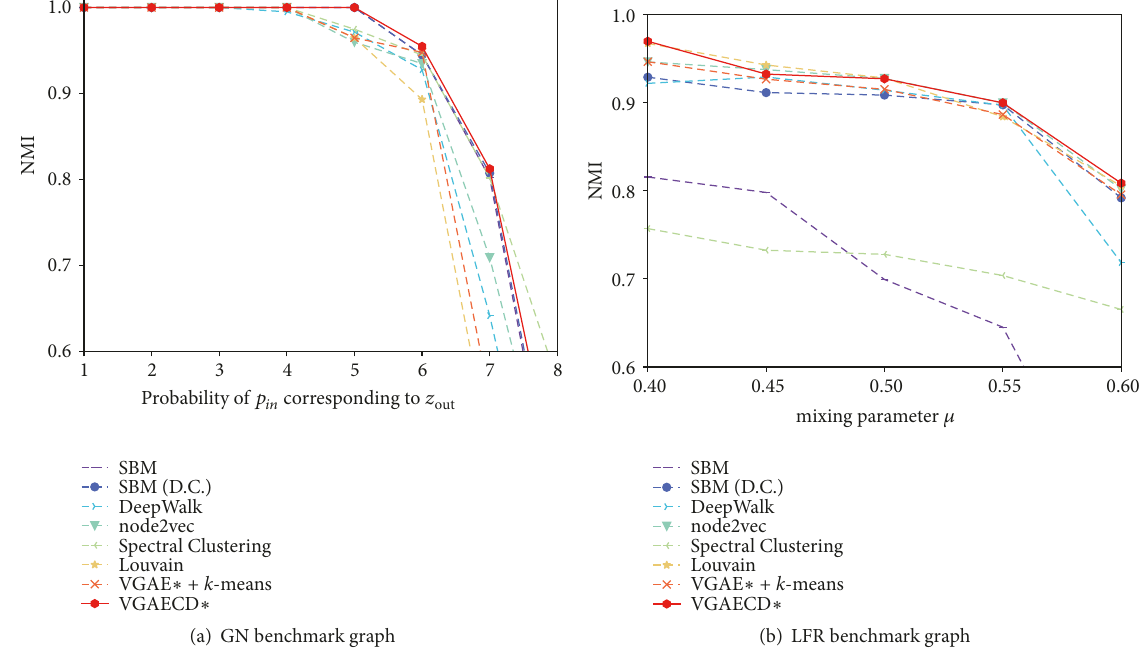
Figure 2: Comparative performance of VGAECD against other methods on synthetic networks.